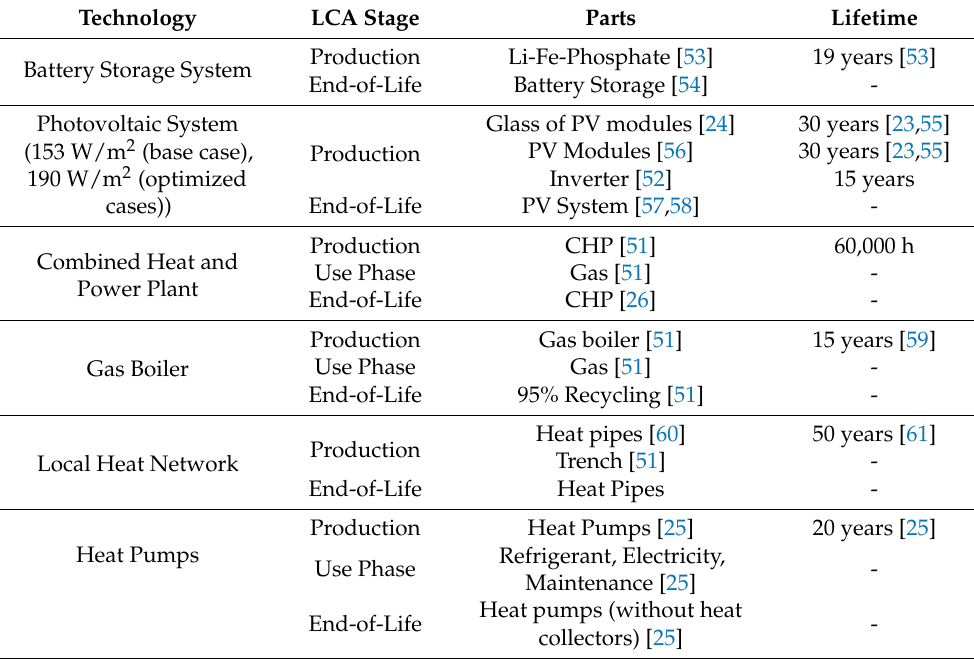
Table 1. Overview of considered technologies, their lifetime, and considered LCA